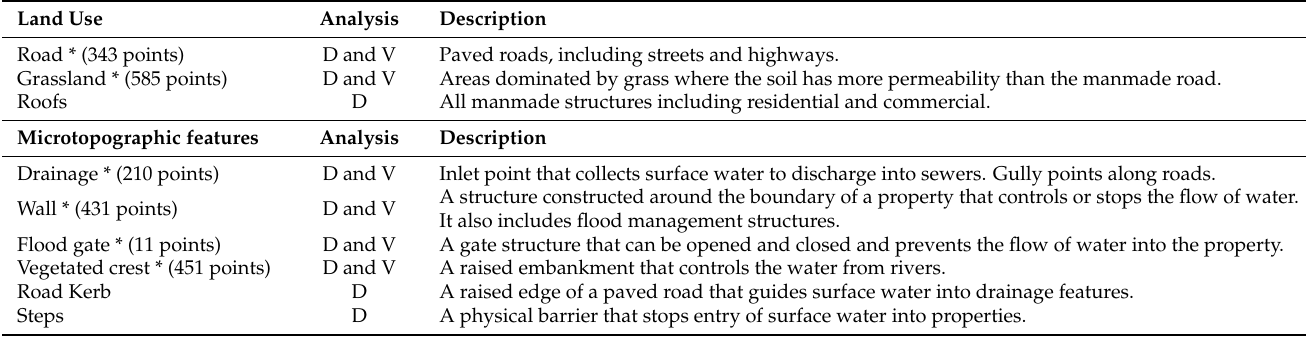
Table 2. Land uses and microtopographic features used in the analysis. * Indicates RTK–GPS ground control points (GCPs; total 2031) that were collected. The number of GCPs collected is provided in